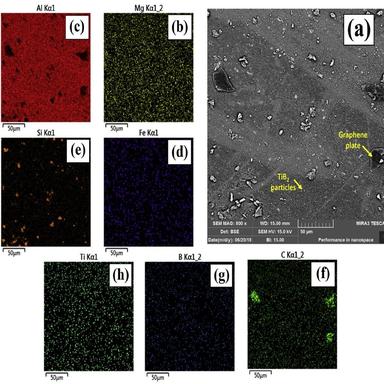
(a) FE-SEM microstructure from the AA6061-1 wt% Graphene-20 wt% TiB2 hybrid nanocomposite as well as the related EDS analysis maps for different elements of (b) Mg, (c) Al, (d) Fe, (e) Si, (f) C, (g) B, and (h) Ti.